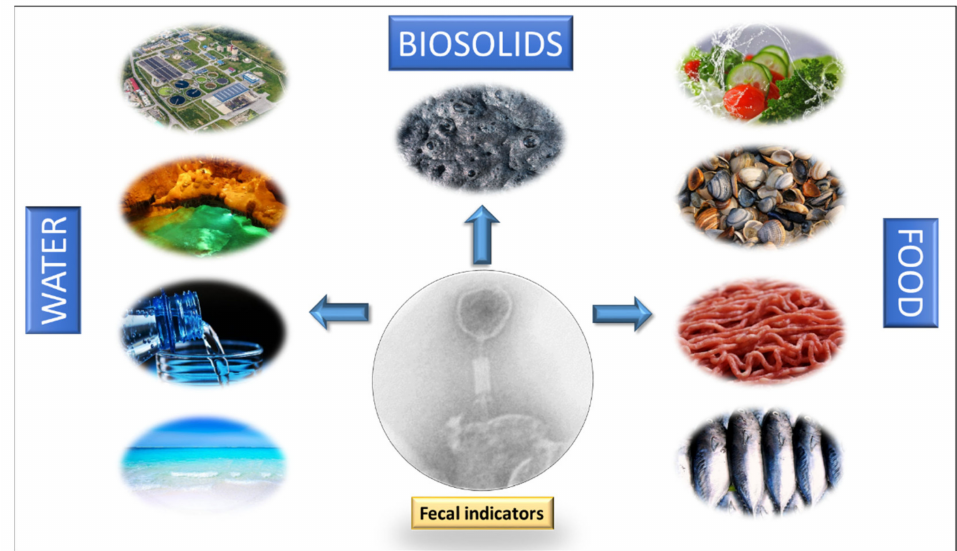
Figure 1. Fields of application of bacteriophages as fecal